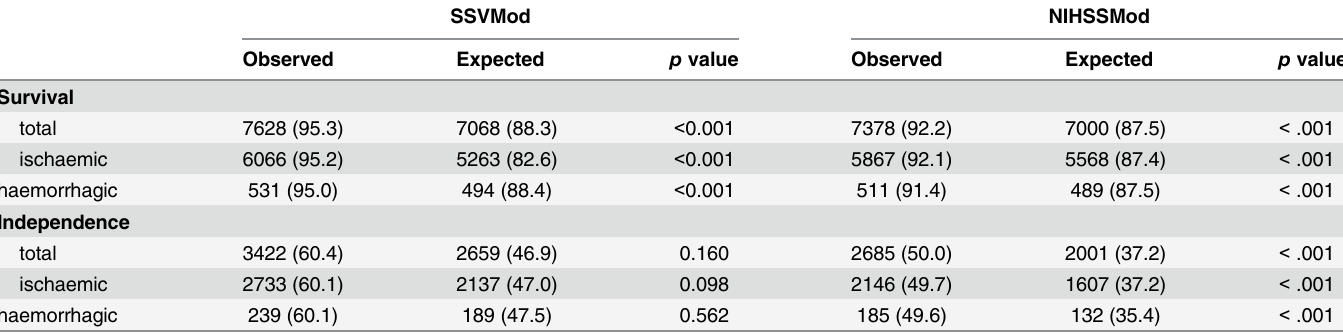
Table 7. Calibration in the large of the models. Data are counts (%); p values are derived from a logistic regression model. Figures are given for all patients and separately for those with ischaemic and haemorrhagic